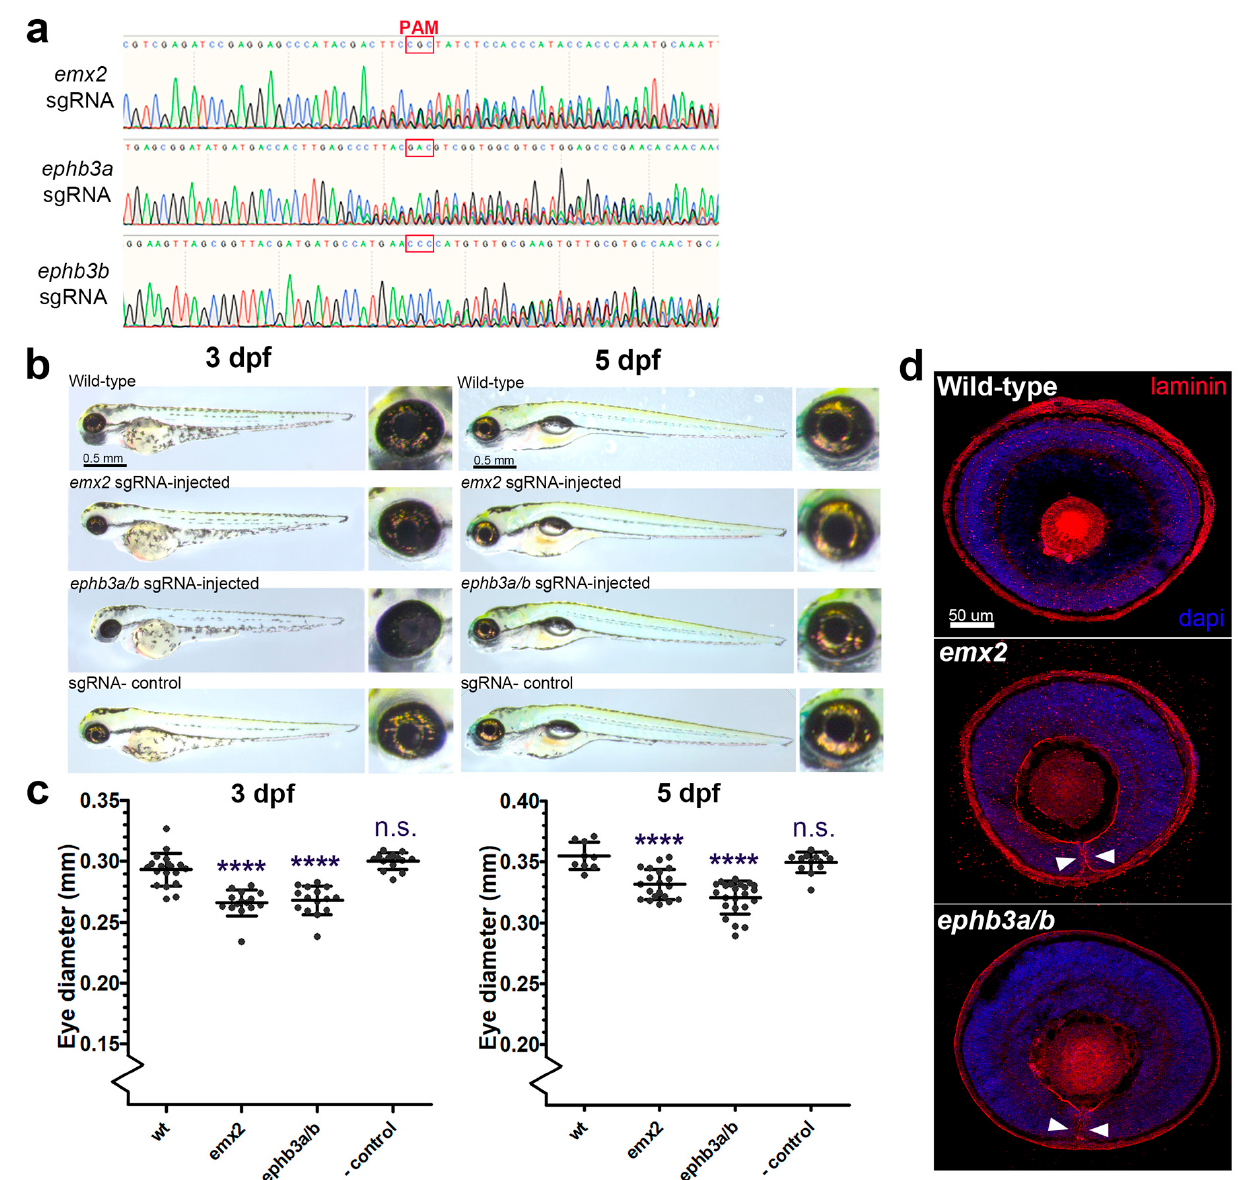
Figure 4. Targeted gene disruption of OFC novel candidates using CRISPR/Cas9 gene targeting in zebrafish embryos. ( a ) Sanger sequence traces for genomic DNA PCR analysis of CRISPR/Cas9 targeted embryos show successful genetic disruption at the sgRNA site loci for eph3ba, eph3bb, and emx2. PAM sites are indicated. ( b ) Brightfield microscopy analysis of targeted fish at 3 dpf and 5 dpf compared to uninjected controls and Cas9-only controls. ( c ) Eye diameter metrics for fish injected with CRISPR/Cas9 at 3 dpf and 5 dpf (*** = p < 0.001, **** = p < 0.0001). ( d ) Confocal analysis of laminin-stained cryosections from gene-edited and control eyes showing persistence of the basement membrane in the optic fissure margin (arrowheads). Colobomas were observed in 27% and 47% of gene-edited embryos analysed for emx2 and ephb3a/b , respectively ( n = 15 per target gene).